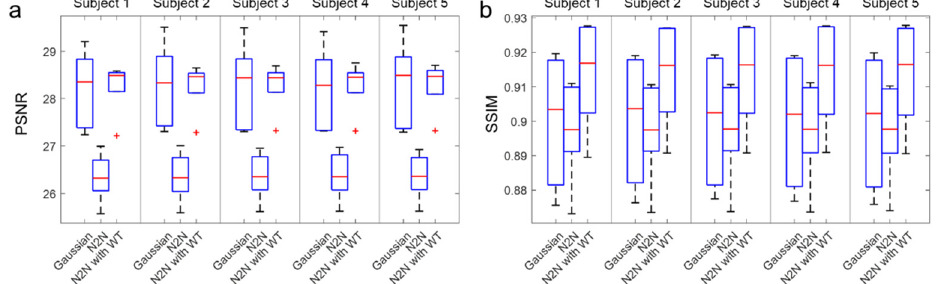
Figure 5. Results of the quantitative analysis for each test subject from the clinical dataset using Gaussian filtering, Noise2Nosie (N2N) without wavelet transform, and Noise2Noise with wavelet transform. ( a ) PSNR and ( b ) SSIM.